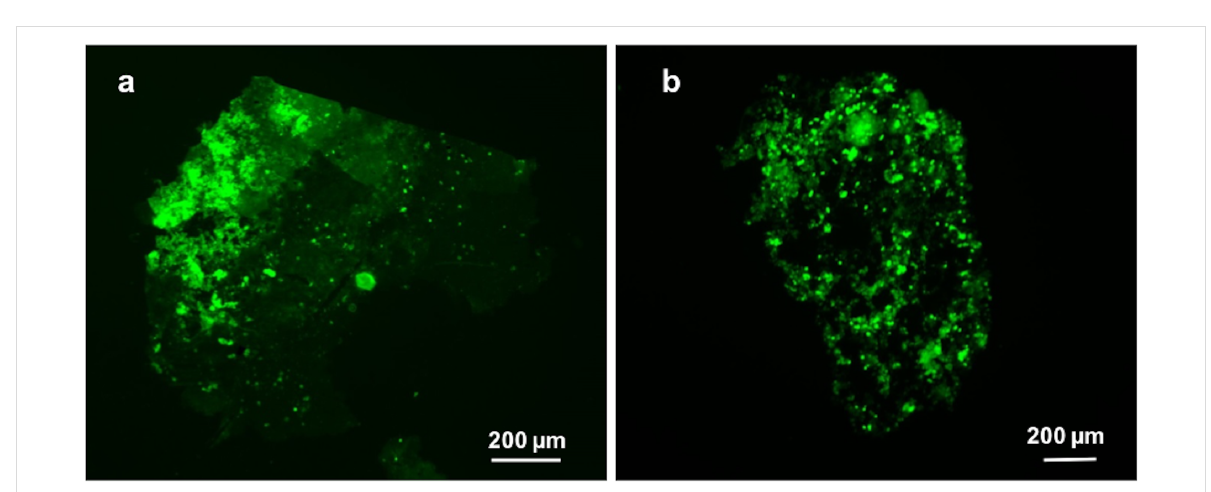
Figure 7: a) Histological staining of the adhesive material deposited by the tube feet of Paracentrotus lividus on glass with thioflavin-T and b) illustra- tion of different adhesive footprints.